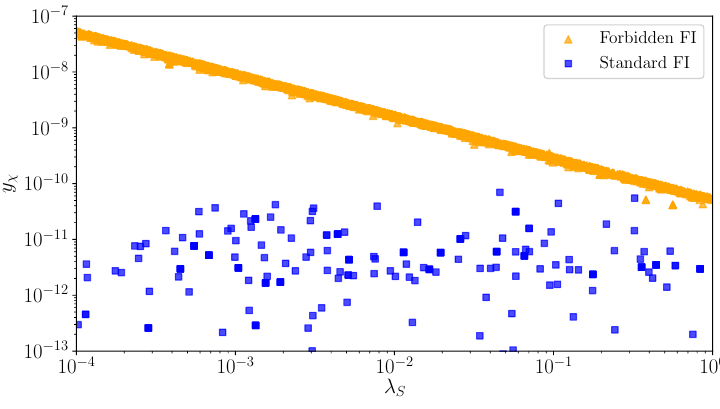
Figure 8. Points satisfying the observed relic density at 95%CL in the plane (cid:21) (orange) and m